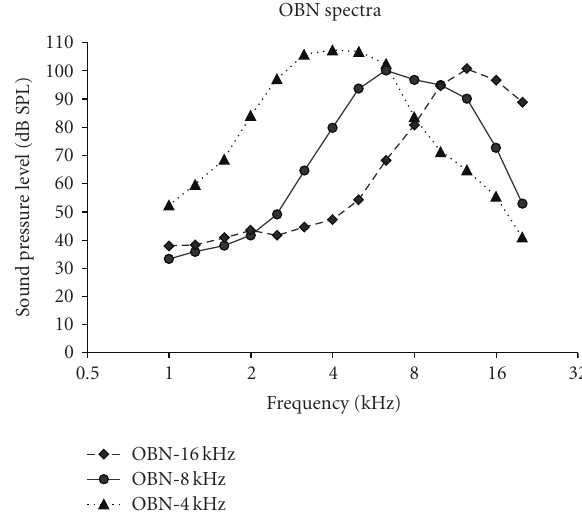
Figure 1: Noise spectra of the 110-dB-SPL octave-band centered at 4 kHz, and the 97-dB-SPL octave-bands centered at 8kHz and